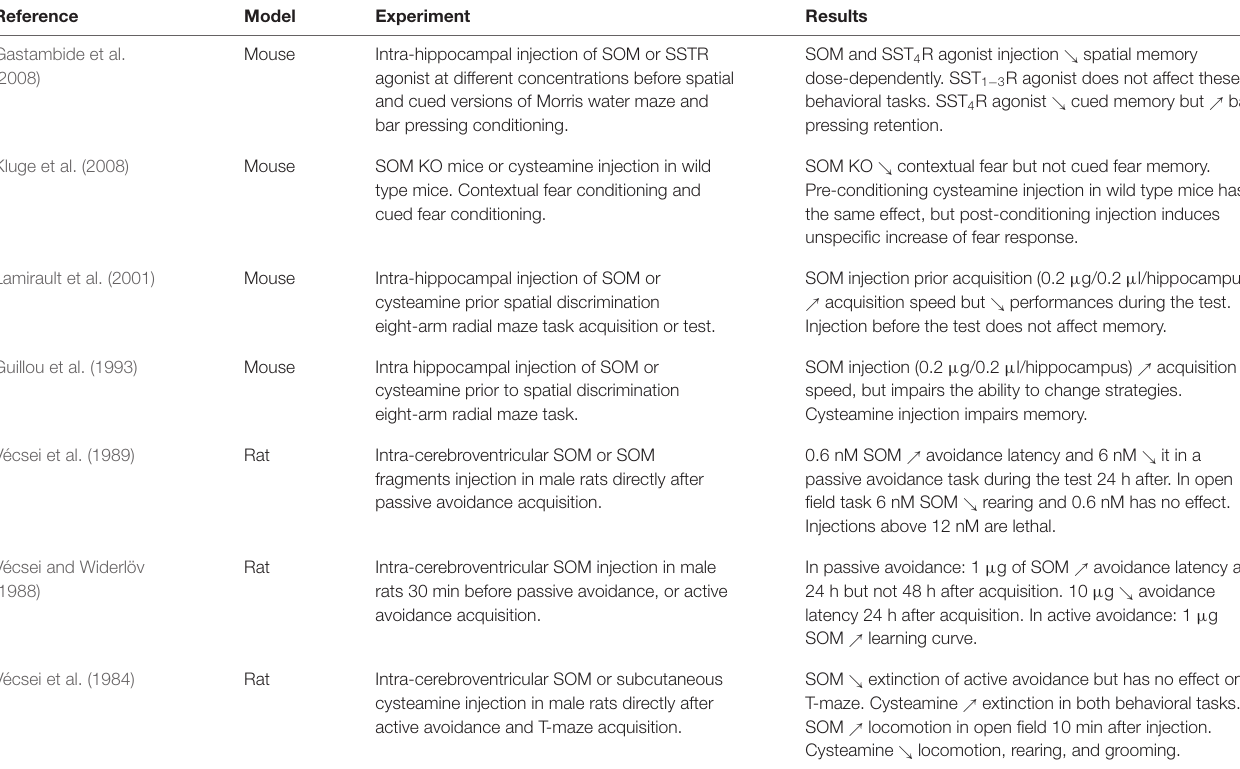
TABLE 2 | Effects of somatostatin (SOM) on hippocampus-dependent behavior. Reference Model Experiment Results Gastambide et al. Mouse Intra-hippocampal injection of SOM or SSTR (2008) agonist at different concentrations before spatial and cued versions of Morris water maze and bar pressing conditioning. Mouse SOM KO mice or cysteamine injection in wild type mice. Contextual fear conditioning and cued fear